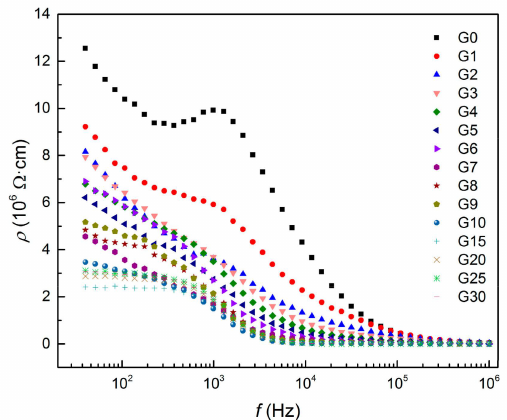
Figure 6. Electrical resistivity of AAS composites with 0 wt%–30 wt% of graphite powder as a function of frequency.